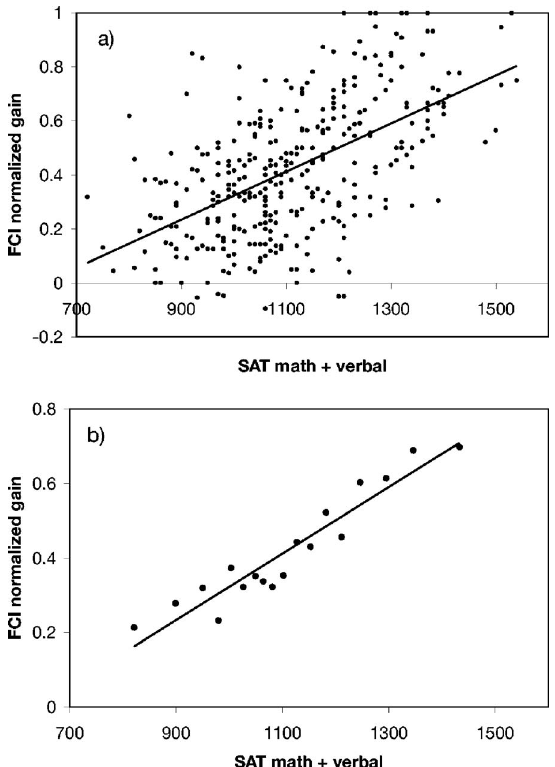
FIG. 2. (cid:1) a (cid:2) Plot of individual students’ normalized FCI gains versus SAT scores for 335 ELHS students: slope=0.00089, r =0.57. (cid:1) b (cid:2) Plot of normalized FCI gains versus SAT scores, with individual student data averaged within 18 bins.